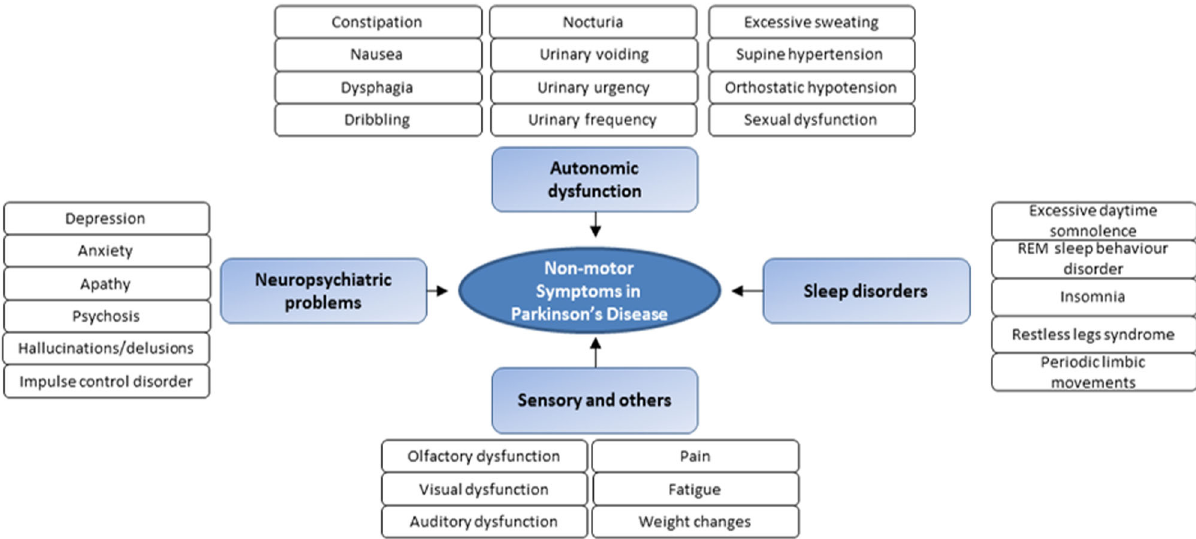
Fig. 1 Diagrammatic representation of the common NMS in PD, as included in the non-motor symptoms scale (NMSS). REM rapid eye movement